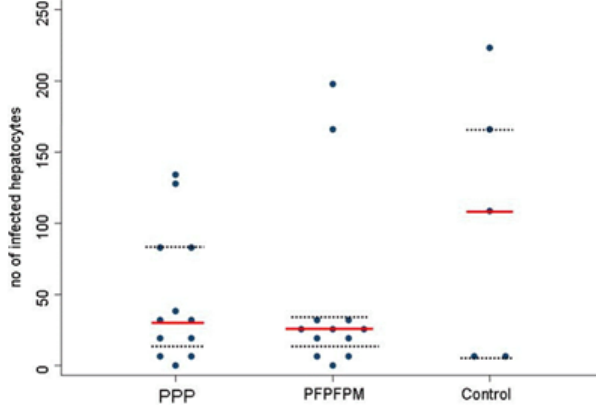
Figure 5. Number of infected hepatocytes. Estimated numbers of infected hepatocytes for individual volunteers are shown. Lines represent the geometric mean for each group with IQ ranges.